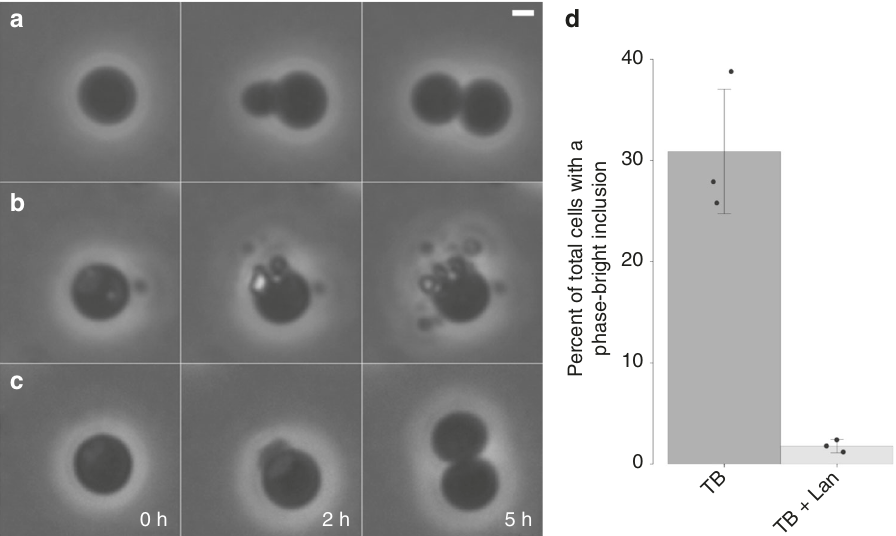
Fig. 3 Terbina fi ne treatment inhibits normal budding replication in Gemmata obscuriglobus . Selected frames of phase-contrast time-lapse microscopy of 4-day G. obscuriglobus cultures. a Control culture. b Culture treated with 100 μ gmL − 1 terbina fi ne. c Culture treated with 100 μ g mL − 1 terbina fi ne and 1 μ g mL − 1 lanosterol. a – c Scale bar represents 1 μ m. d Incidence of phase-bright inclusions in TB-treated culture with or without lanosterol supplementation. Phase- bright inclusions were never observed in untreated cultures. Means and standard deviations are shown for three biological replicates. Source data are provided as a Source Data fi